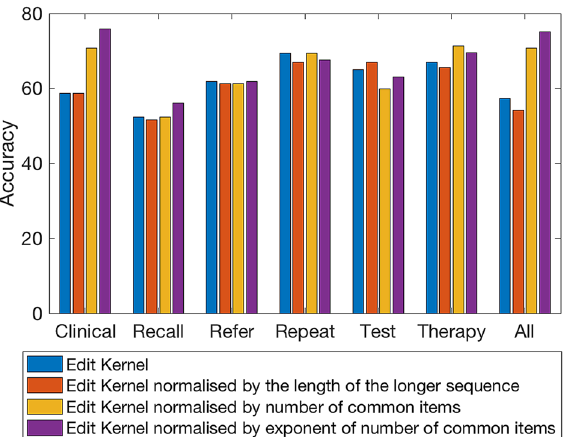
Figure 7. Bar chart showing the corresponding Accuracy obtained by applying the 4 kernel functions to the datasets.